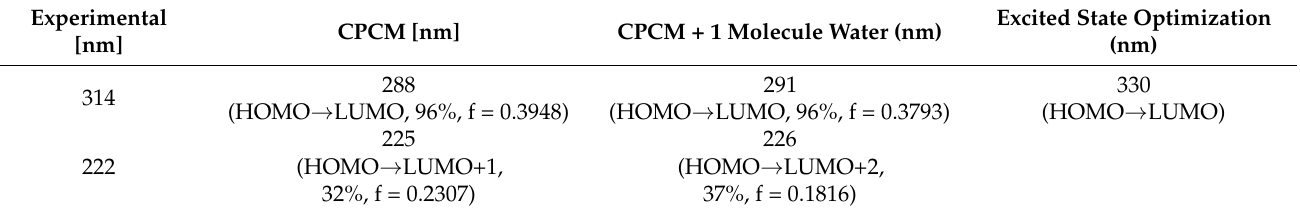
Table 3. Experimental and theoretical (at M05-2X/6-311++G(d,p) level of theory) electronic transitions of